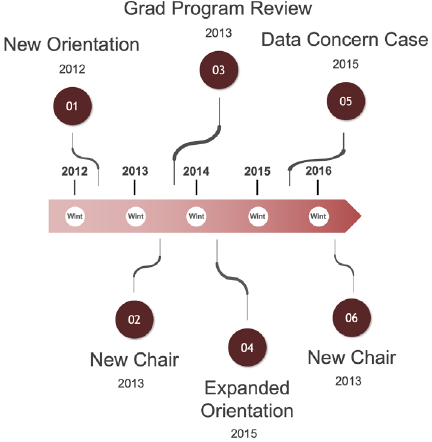
FIG. 1. Short timeline of change elements that occurred before the tragedy that sparked larger policy